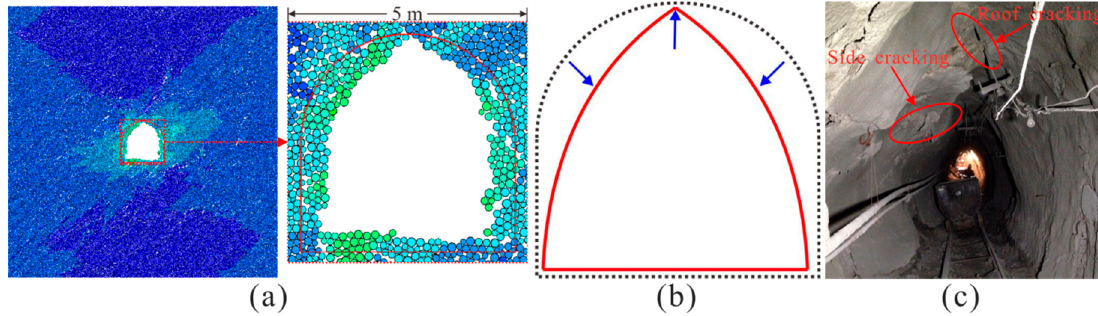
Figure 12. Schematic diagram of pointed roof failure. ( a ) Numerical simulation result; ( b ) Failure mechanism; ( c ) Field